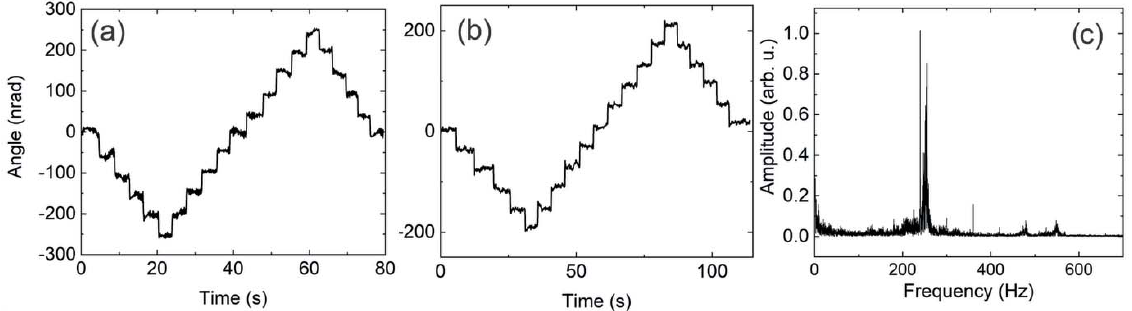
Figure 5 Characterization of the KB manipulation system. Panels ( a ) and ( b ) demonstrate 50 nrad angular motion of the horizontal and vertical mirrors, respectively. The angular motion has been verified by an external laser interferometer. Panel ( c ) demonstrates the fast Fourier transform spectrum of the vertical mirror flexure assembly. The fundamental resonance frequency is (cid:2) 250 Hz, making it less sensitive to ambient and cultural